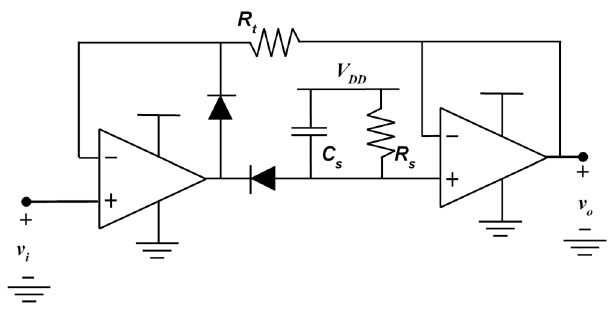
filter (BPF). ( b ) Measured Bode plot of the cascade of the difference amplifier and the 4th-order BPF.